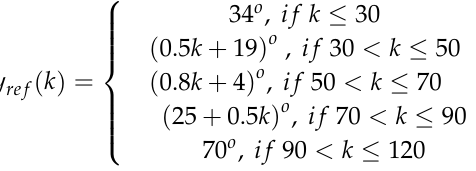
Figure 27. Learning curve of the FNFN controller in the water bath system.